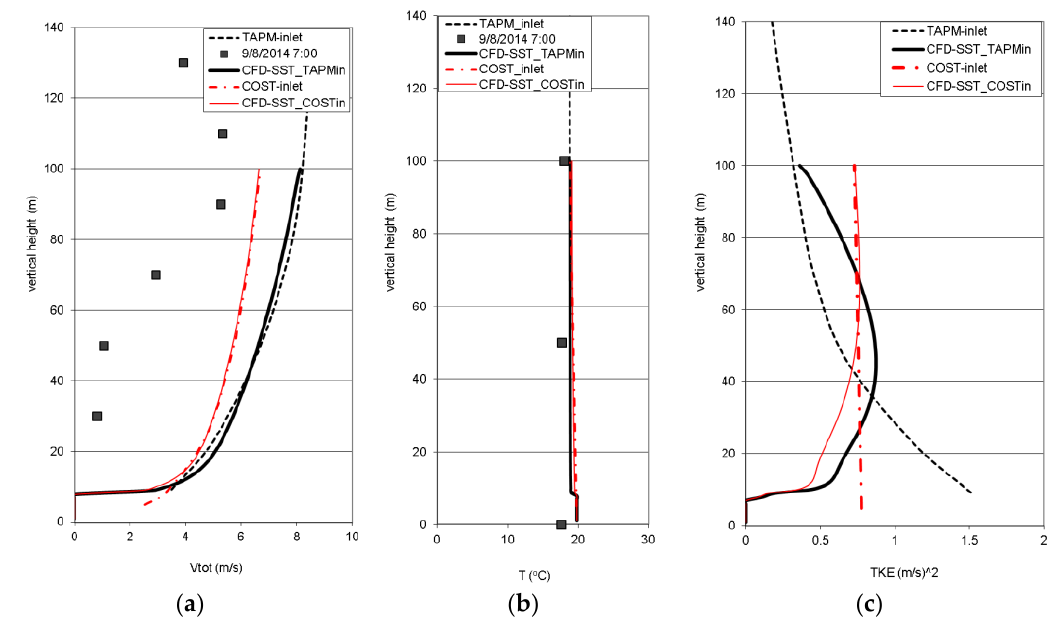
Figure 8. ( a ) Vertical profiles of wind speed and ( c ) wind turbulence kinetic energy over position 2 and ( b ) air temperature over position 1 (Figure 1). CFD results, neutral atmosphere (D in Table 1), SST turbulence model and inlet profiles from mesoscale results (“TAPM-inlet”) and from the COST 710 recommendations (“COST-inlet”).